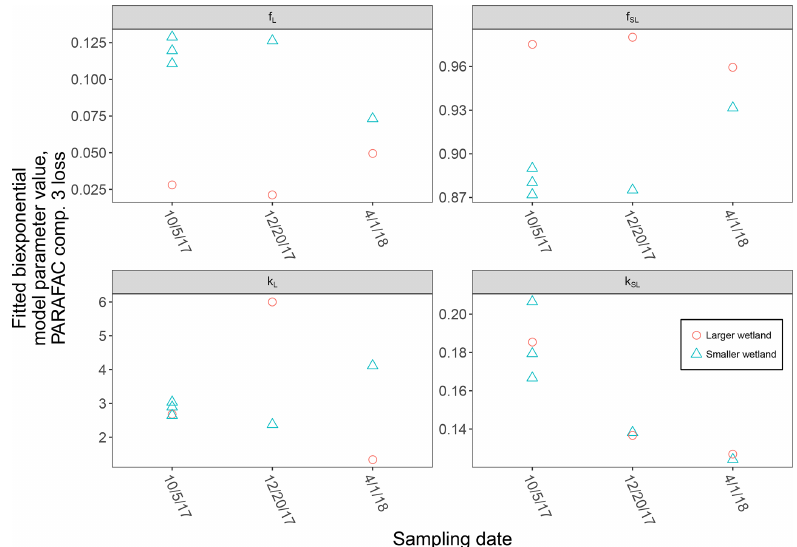
Figure A4. Fitted biexponential model parameters (Eq. 3) from the time series of PARAFAC component four, comparing DOM from the large and small wetland sampling sites collected on different dates. f is unitless, and k is m 2 [molphotons] − 1 .